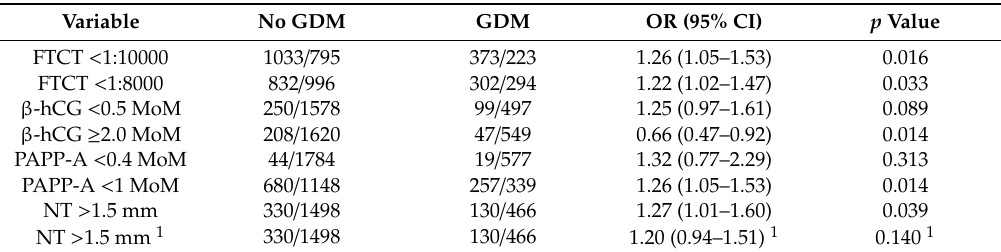
Table 3. Association of FTCT parameters with